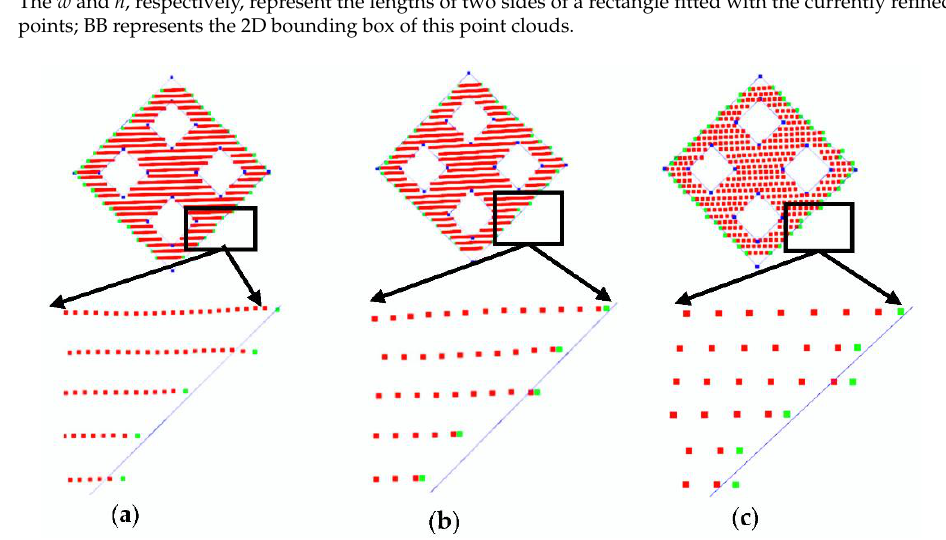
Figure 9. Refined edge point visualization results. Red points are the points scanned by LiDAR; green points are refined edge points. The blue lines are the boundary lines as large as the calibration object. ( a ) is the display of refined points when 𝜃 = 0.1° , ( b ) is the result when 𝜃 = 0.2° , and ( c ) is the result when 𝜃 = 0.4°.